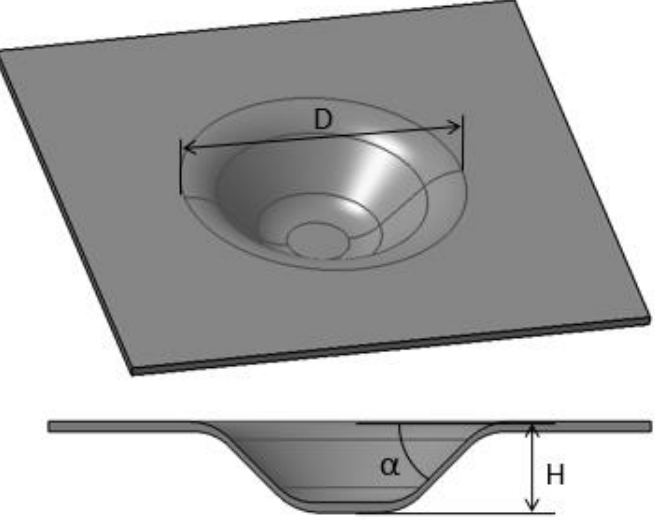
Figure 8. Dimensional parameters used in parts codification, reprinted with permission from ref.